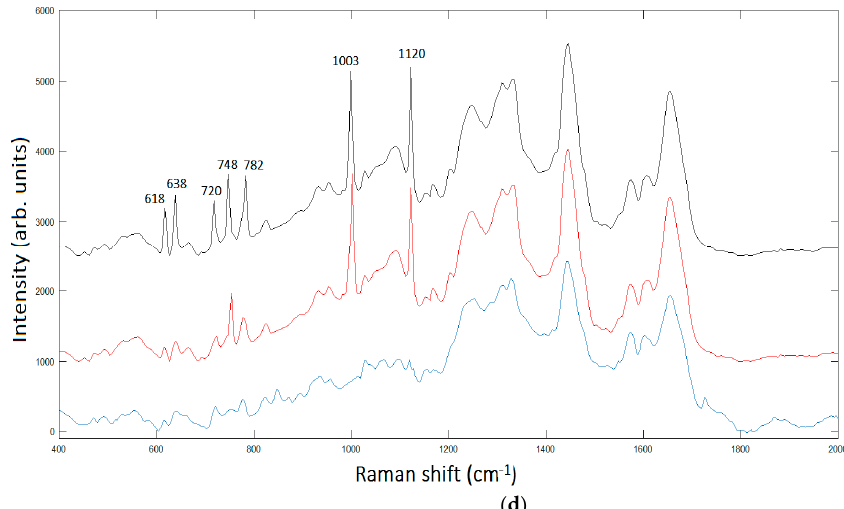
Figure 6. ( a ) Denotes the bright-field image of MG-63 nuclear area where the bright points display the AuNSs, scale bar 1 μ m, ( b ) represents the correspondent Raman map of the area marked by the red box in ( a ). The labels 1 and 2 mark a non-SERS and a SERS domain characterized by the AuNSs dimer. ( c ) Shows the Raman map calculated with Green’s function: the red regions denotes the spatial areas with Γ 2 ~10 5 . ( d ) Displays the Raman spectra in the recorded Raman map, label 1 (blue line), label 2 (red line) and in 2 after data processed with simulated map ( c ), black line.